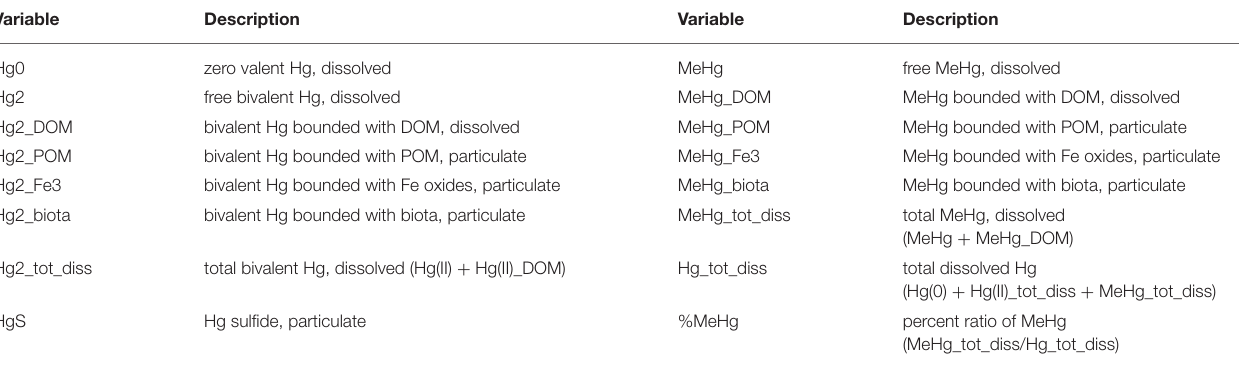
TABLE 2 | Variables used in brom_hg .